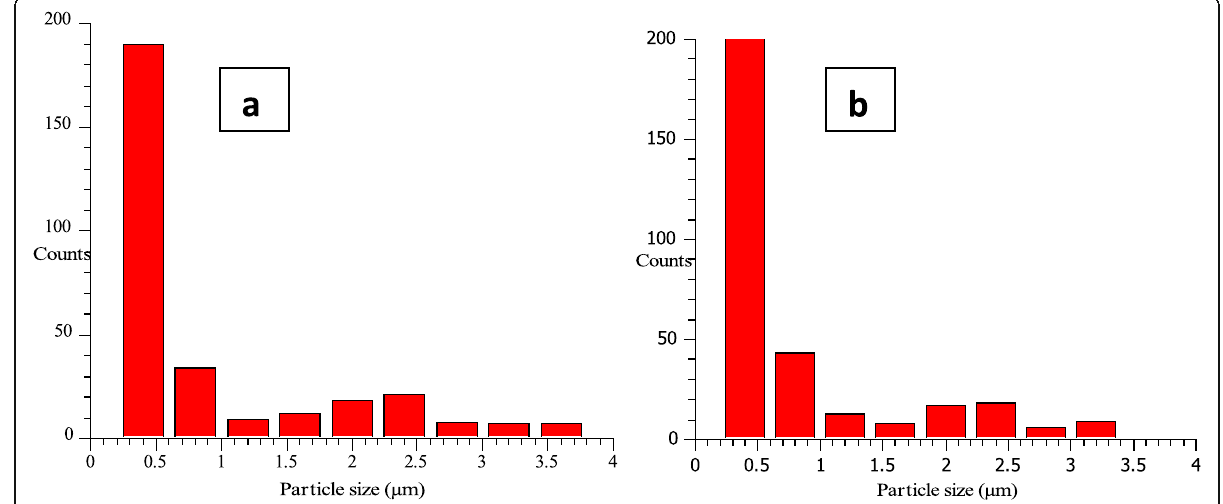
Fig. 5 Particle size distribution for the synthesized silver nanoparticles using plant extracts of a Moringa oleifera and b Ficus